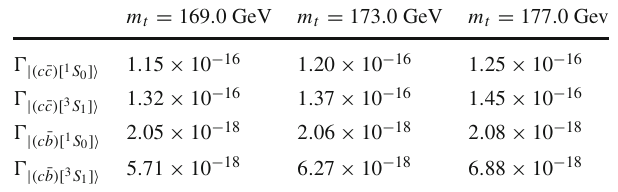
Table 4 Uncertainties of the decay width for the process t → | ( c ¯ Q ) [ n ](cid:5) + Q + Z 0 by varying m ∈ [ 169 . 0 , 177 . 0 ] GeV t m t = 169 . 0 GeV m t = 173 . 0 GeV m t = 177 . 0